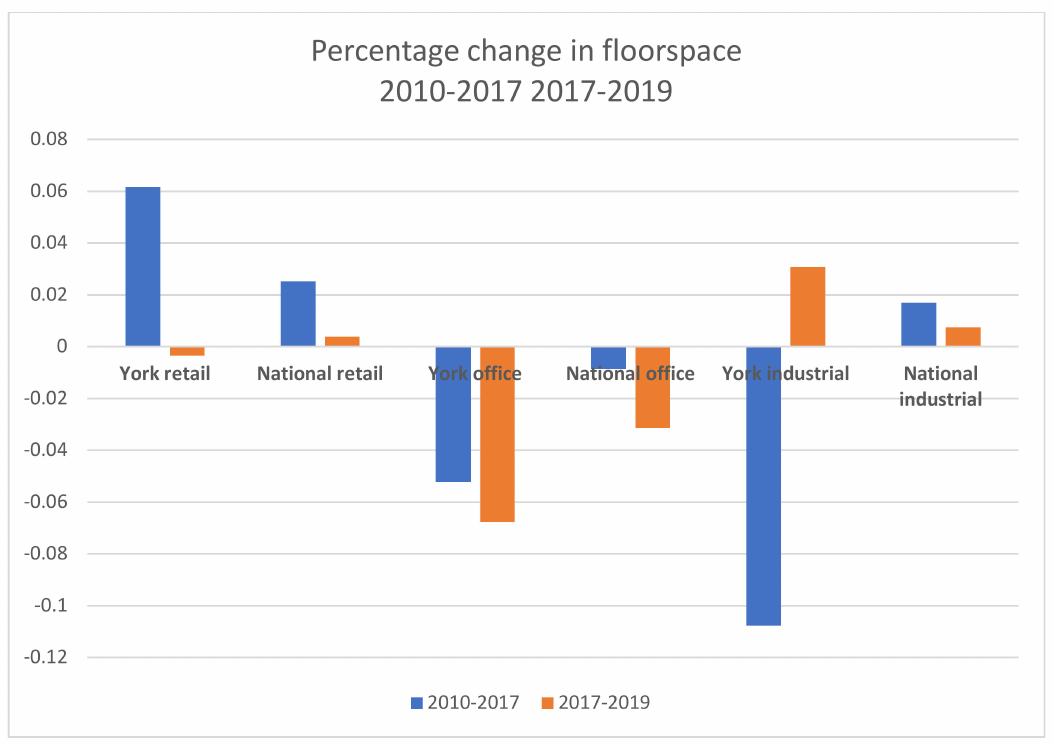
Figure 6. Comparative percentage change in aggregate floorspace, York and England and Wales (National)